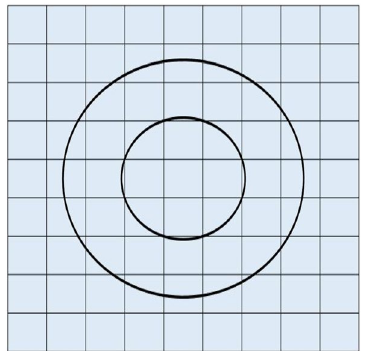
Fig. 22 Finite element mesh used in the analysis and unfitted boundaries